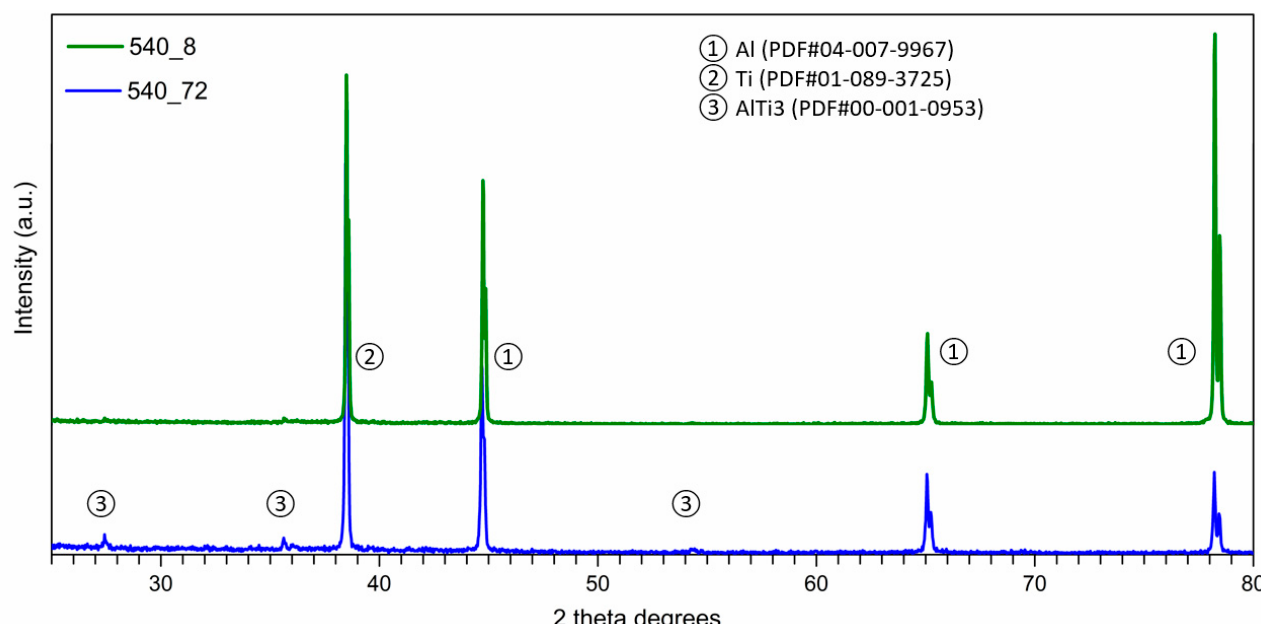
( d ) Figure 10. The microstructures of composites after heat treatment at 600 °C at varying times: ( a ) 2 h; ( b ) 8 h; ( c ) 24 h; ( d ) 72 h (SEM).